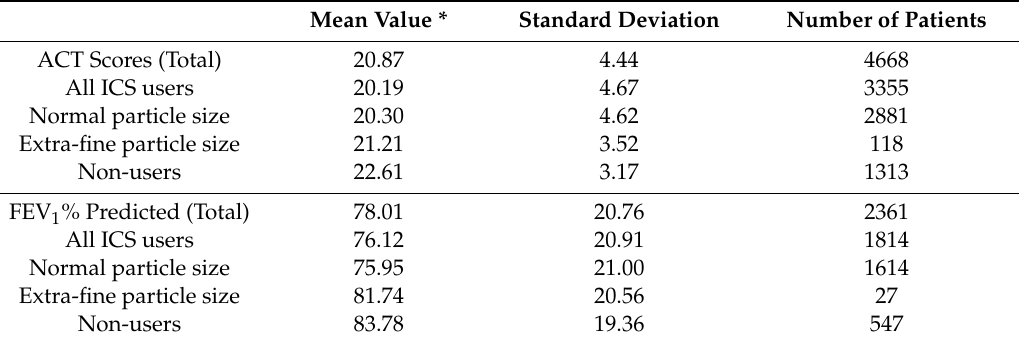
Table 3. Mean ACT and PFT values by ICS particle size.